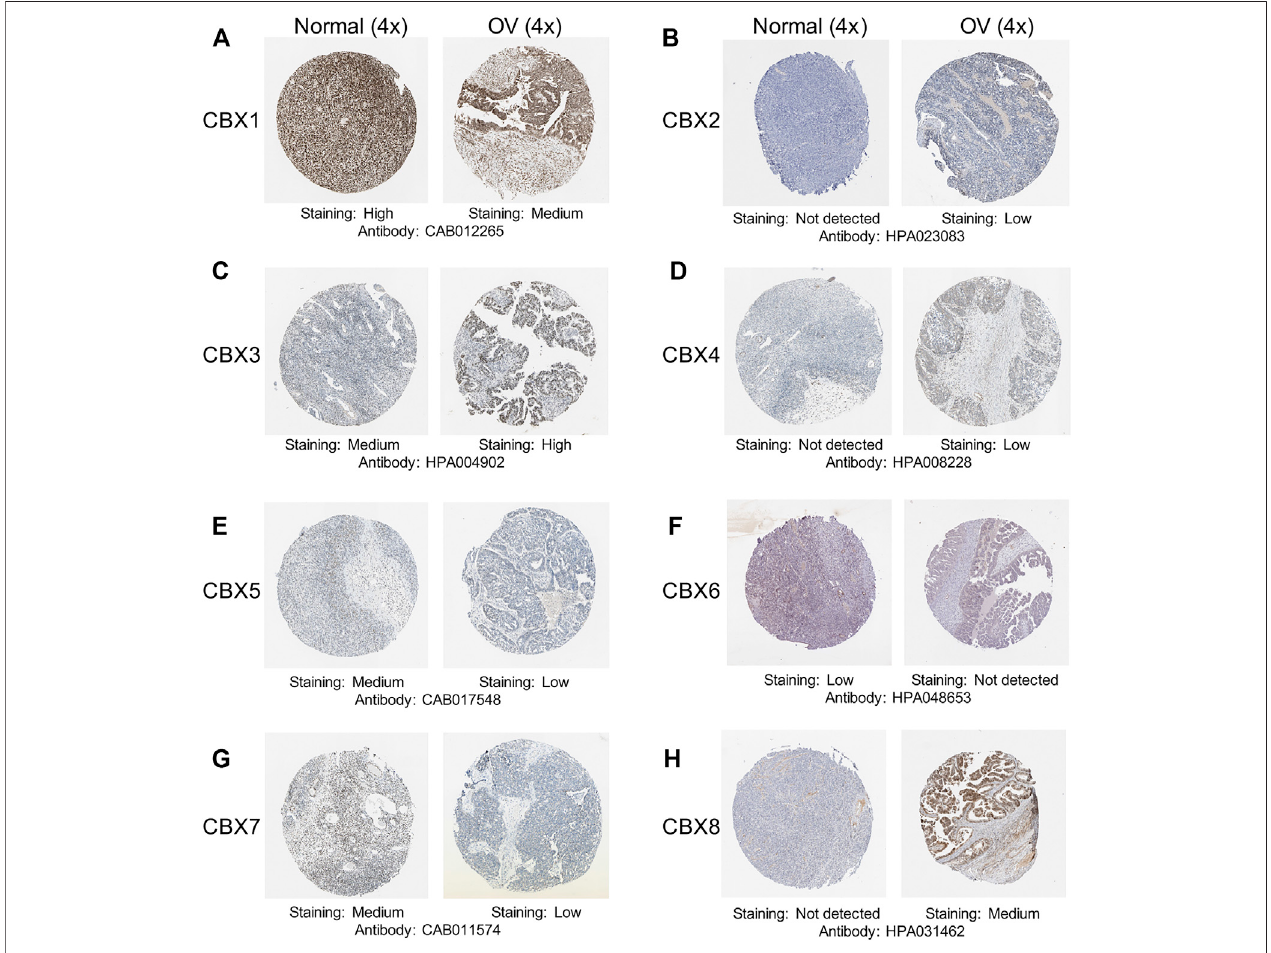
FIGURE 2 | Representative immunohistochemistry images of the CBXs family members in OV tissues and normal ovarian tissues. (A – H) The protein expression pro fi les of CBX1-8 were collected from the Human Protein Atlas database.